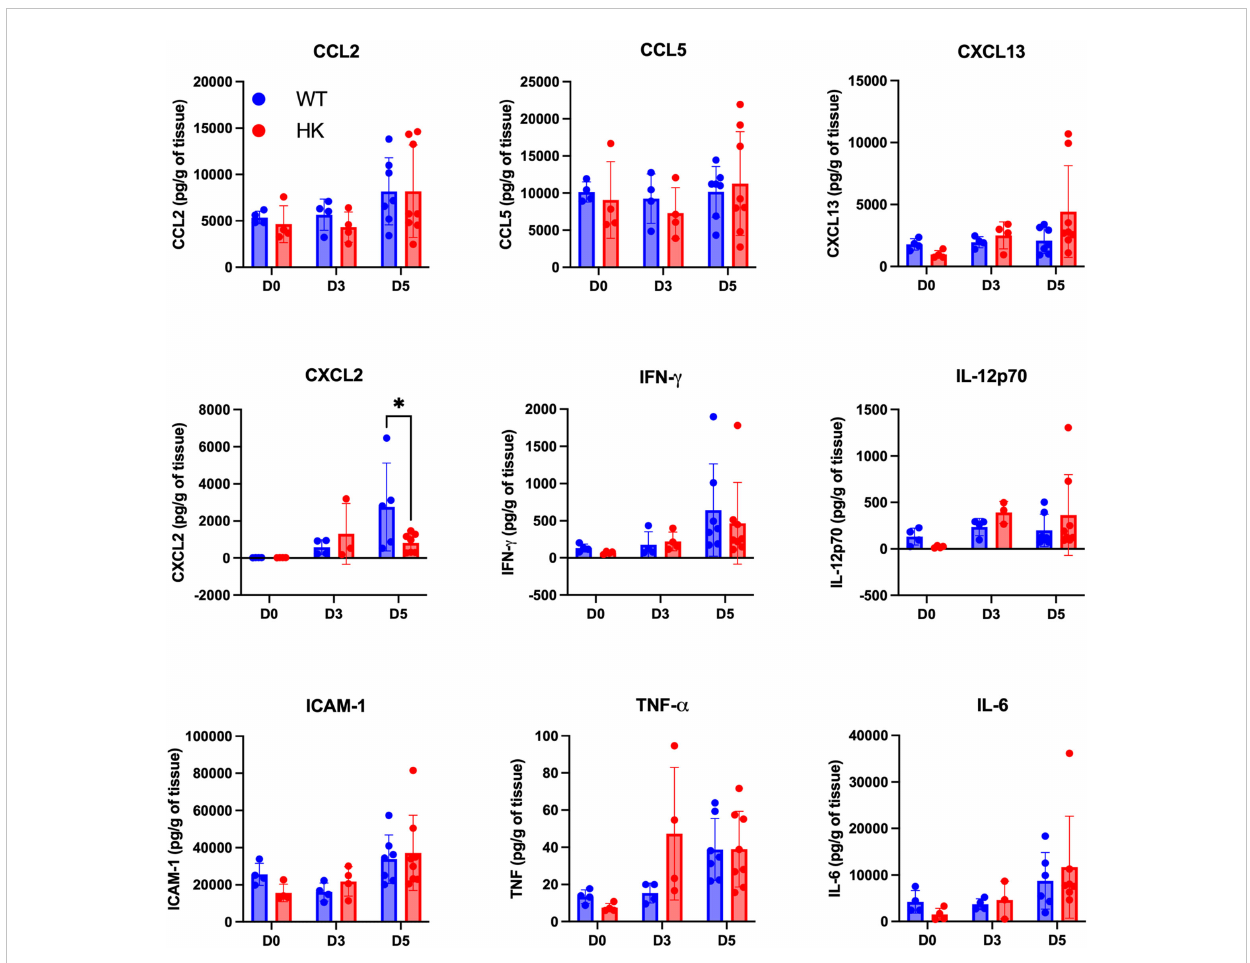
FIGURE 6 Mast cells modulate the chemokine milieu of the female reproductive tract following Chlamydia infection. Female reproductive tract homogenates from mast cell-de fi cient HK mice and littermate controls at baseline, D3 post-infection, and D5 post-infection were analyzed on a multiplex assay for soluble mediators, including chemokines and cytokines. Concentrations were normalized and graphed as per gram of tissue. Each dot represents an individual mouse. * p < 0.05, as determined by two-way ANOVA and Sidak ’ s multiple comparison